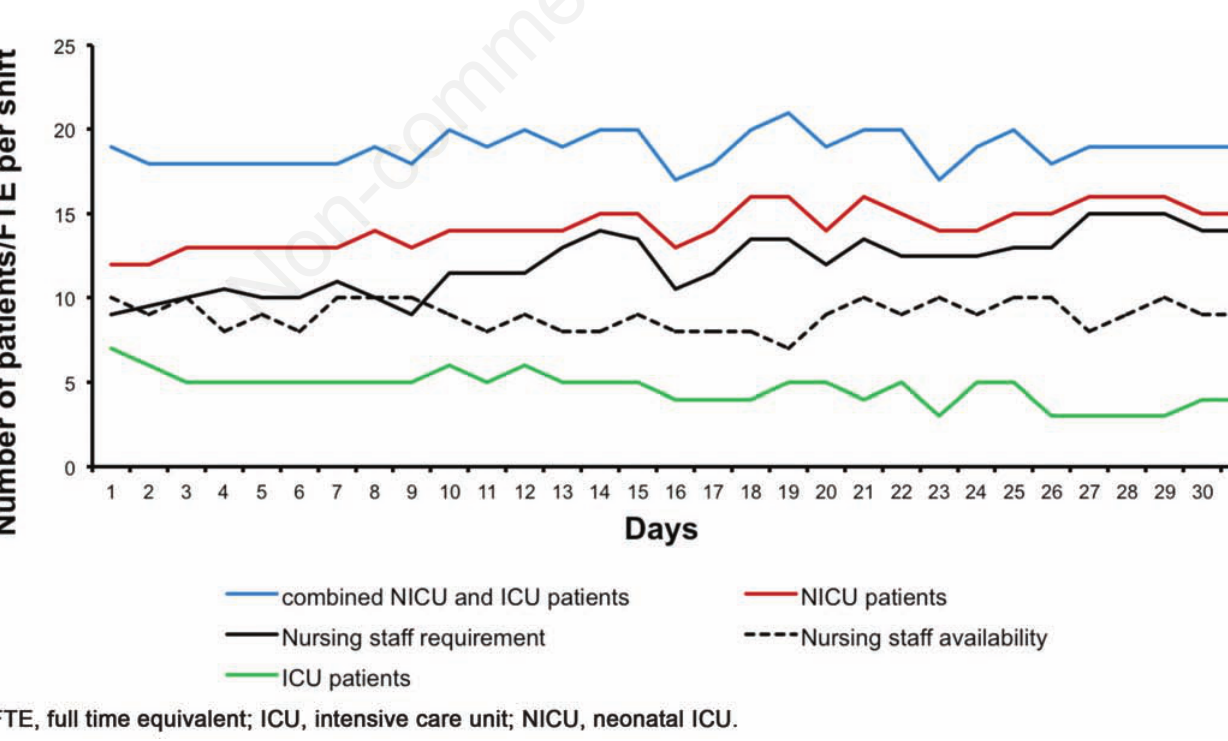
Figure 2. Comparison of the calculated daily mean nursing staff requirement per shift based on the number of neonatal patients in British Association of Perinatal Medicine (BAPM) category of care 1 and 2 and the actual nursing staff availability per